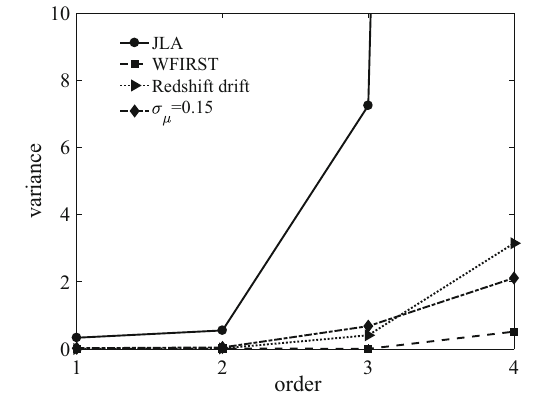
Fig. 7 Variance for different cosmographic series truncations in the y -redshift by current and future